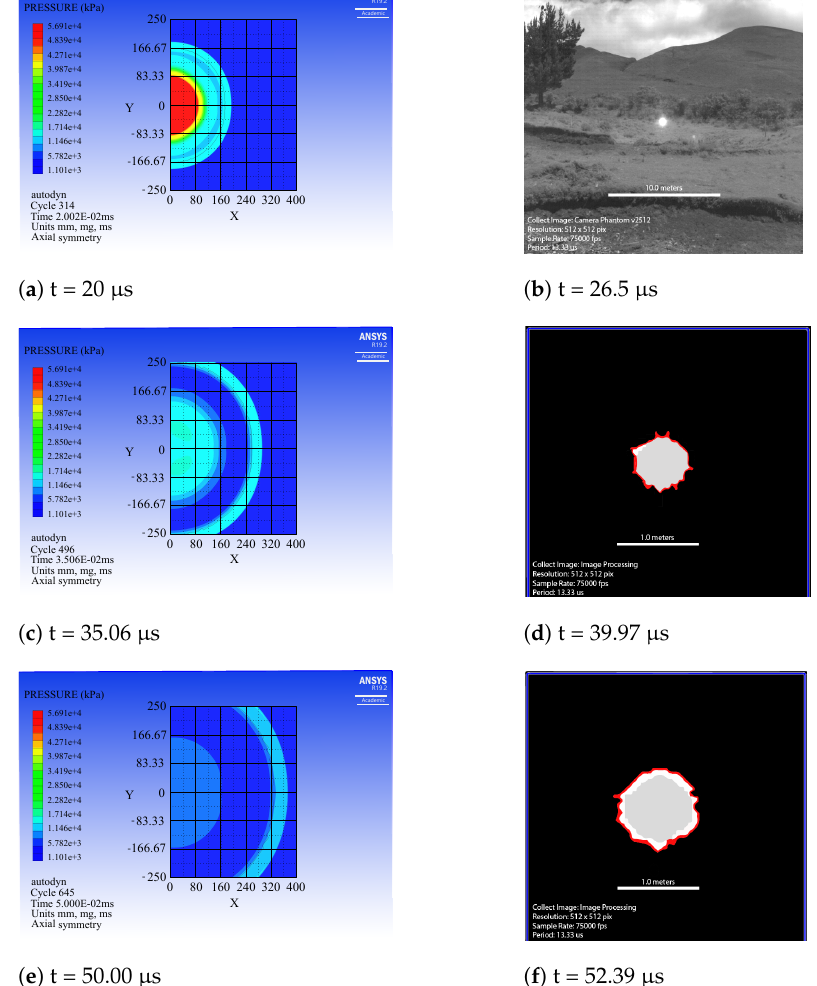
Figure 10. Numerical and experimental results for spherical charge of 150 g of